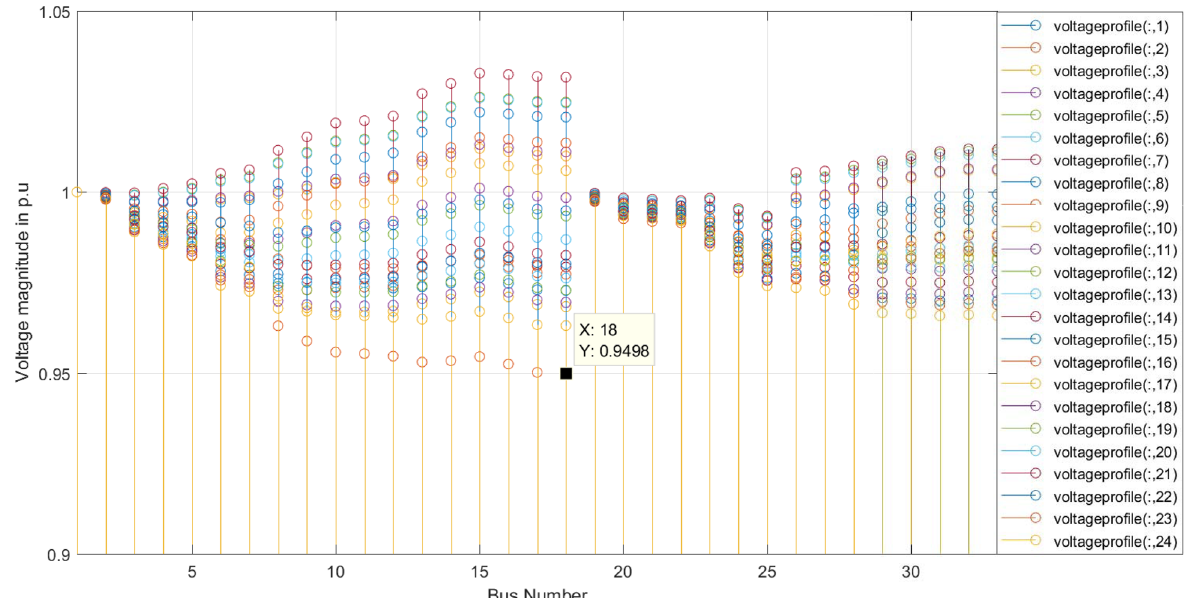
Fig. 9 Voltage profile of the test system after optima placement of DGs at 0.9pf by